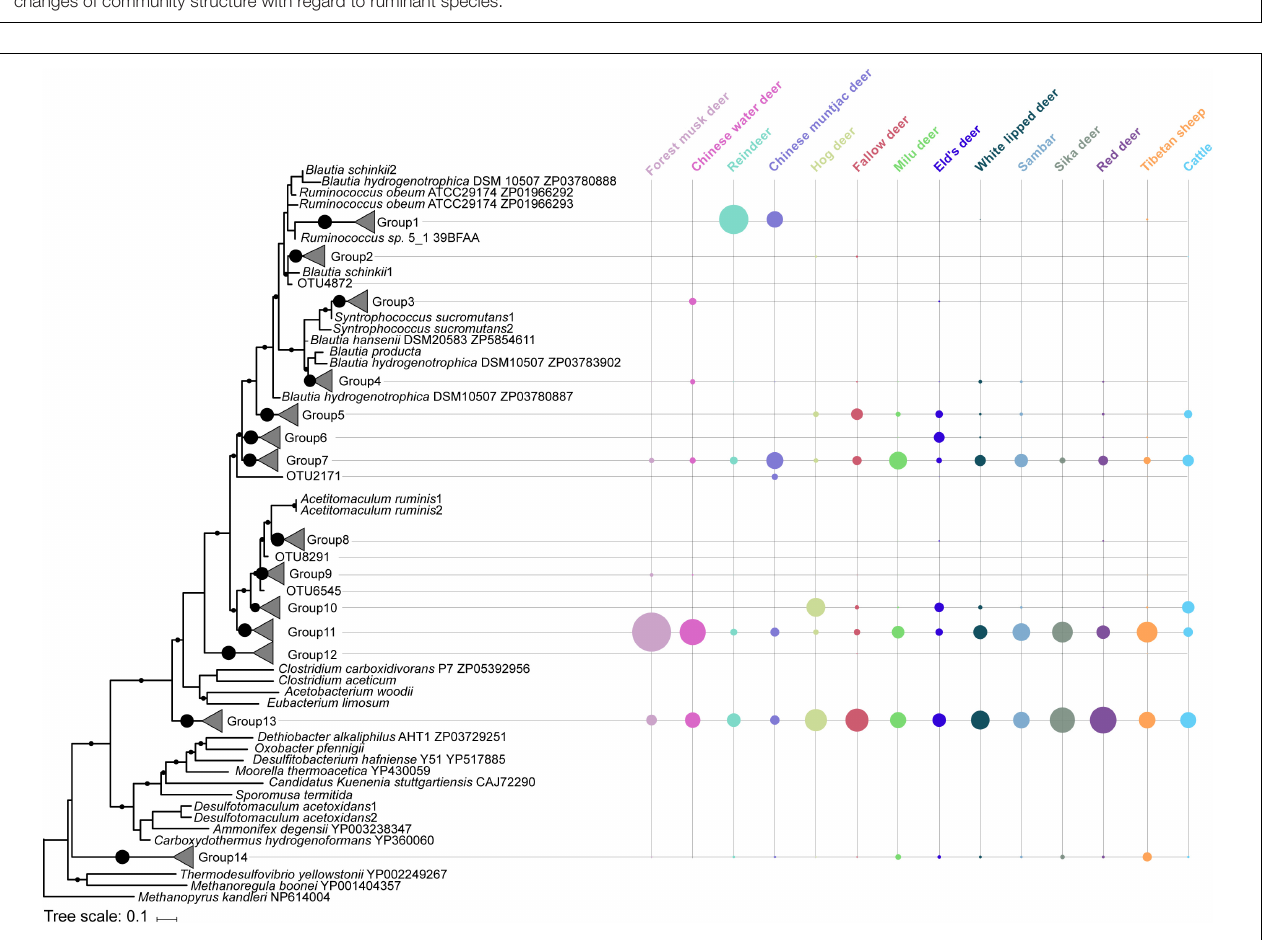
FIGURE 2 | Comparisons of the methanogen and acetogen communities in the rumen of 14 species. (A) Principal coordinates analyses based on the Bray–Curtis distance of methanogens in the rumen of 14 ruminant species. (B) Principal coordinates analyses based on the Bray–Curtis distance of acetogens to reveal the changes of community structure with regard to ruminant species.